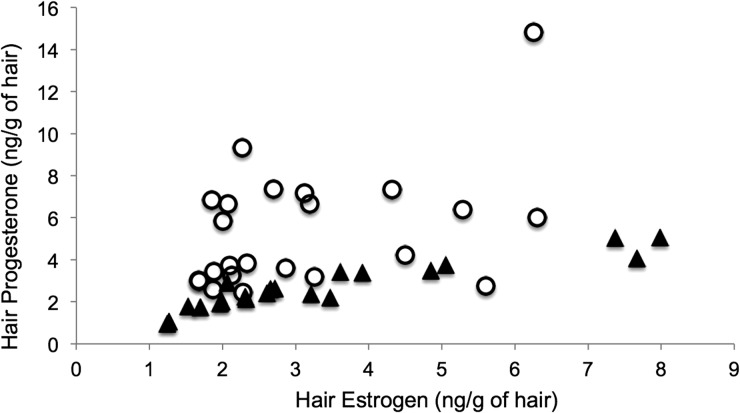
Relationship between progesterone and estrogen (in nanograms per gram of hair) for wild adult Canada lynx pelts of known sex. Open circles, female; and filled triangles, male.